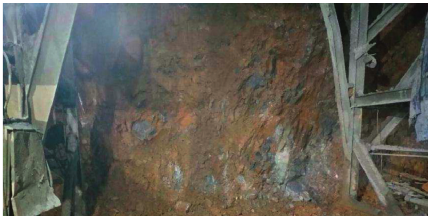
Figure 15: Disaster accident of mud bursting and water bursting during tunnel